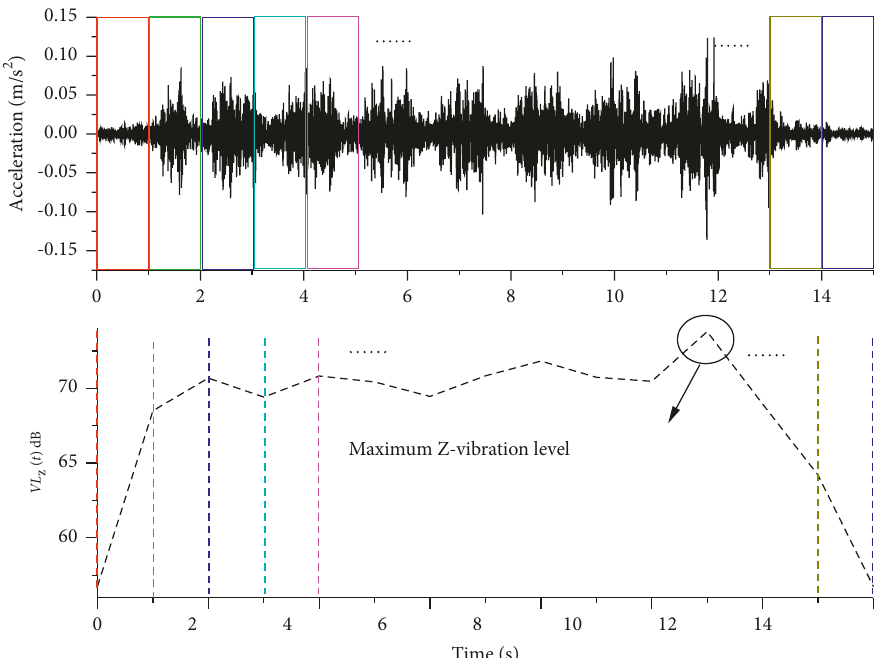
Figure 2: Illustration of calculation method for maximum Z-vibration